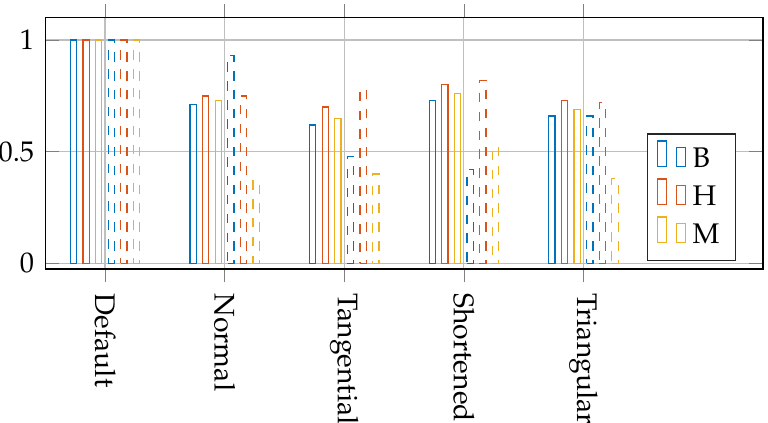
Figure 9. Fractional dependency of the inclination angles due to changed pole shoe design for the linear machine under load. Solid bars indicate the averaged fractional values and the dashed bars indicate the maximum fractional values, both also tabulated in Tab. 4.